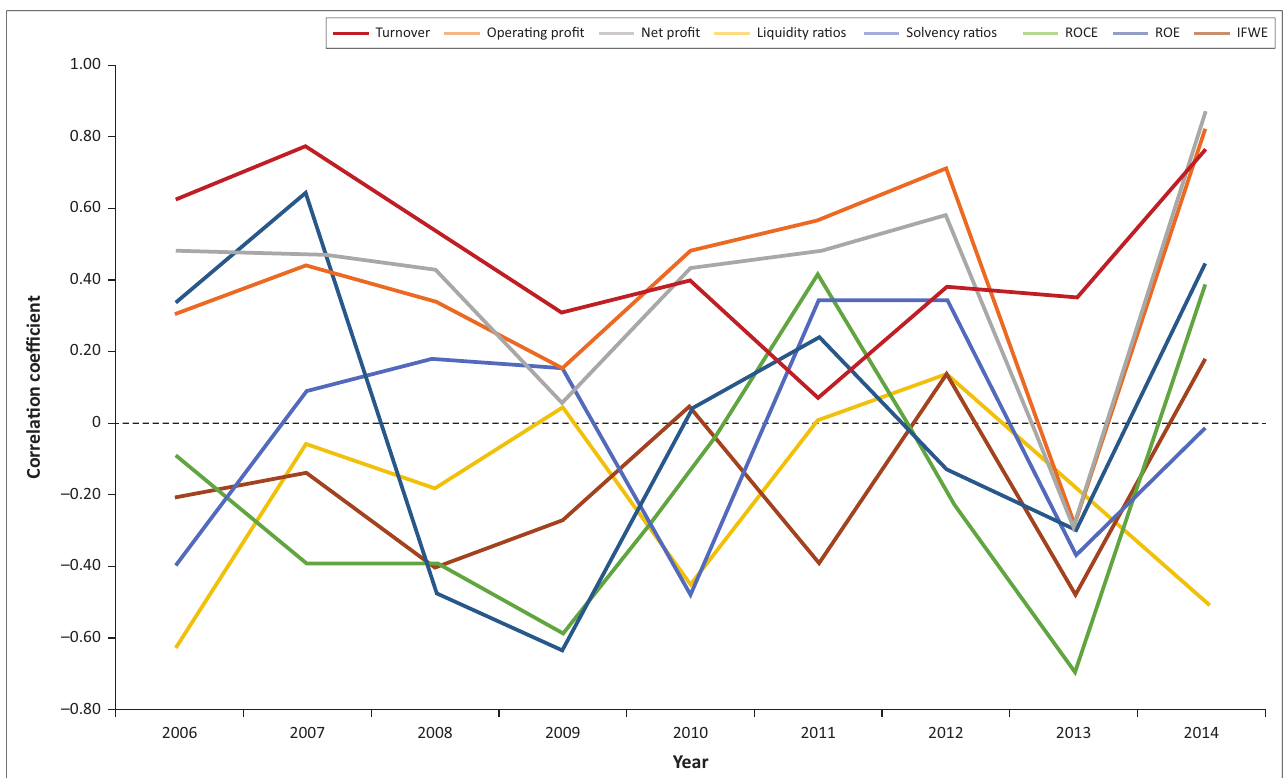
FIGURE 2: Short-term incentives and state-owned companies’ performance. ROCE, return on capital employed; ROE, return on equity; IFWE, irregular, fruitless and wasteful expenditure.